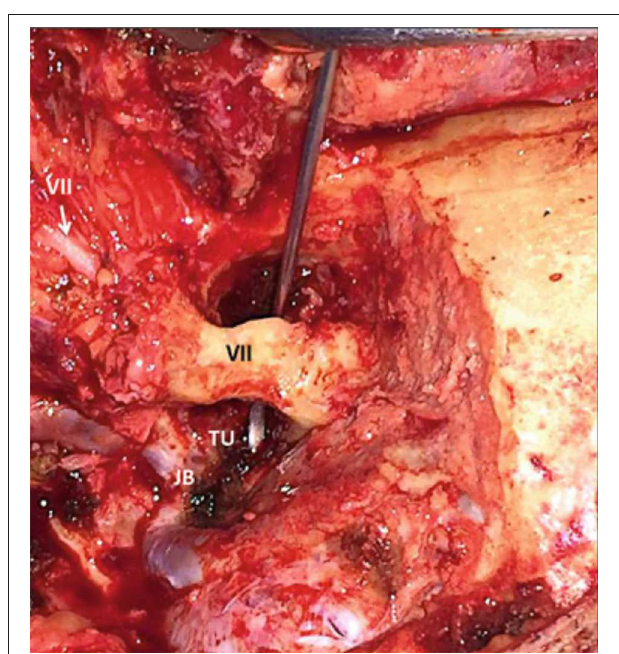
FIGURE 14 | After radical mastoidectomy, the facial nerve is left protected by bone inside the fallopian canal, with a hook passing below the canal to show the working space to resect tumor in the hypotympanum (3). JB, jugular bulb; TU, tumor; VII, facial nerve in the fallopian canal (black) and entering the parotid gland